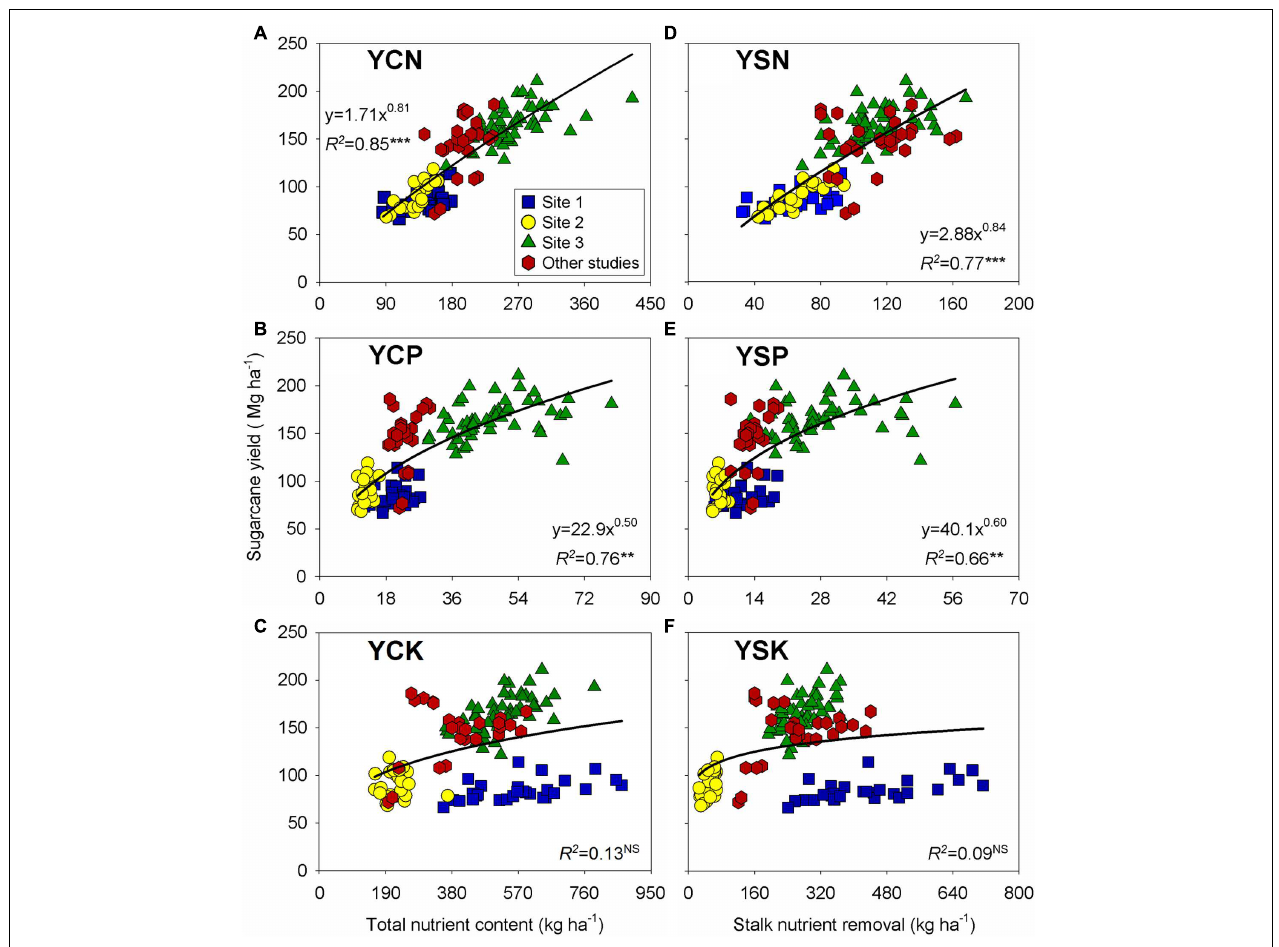
FIGURE 3 | Relationships between sugarcane yield versus aboveground nutrient content for N (A), P (B), and K (C); and versus stalk nutrient content (nutrient removal) for N (D), P (E), and K (F). Each data point represents an individual field plot at sugarcane harvest of a first ratoon growing season for three site-years ( n = 102). Red symbols were gathered from previously published documents (Shukla et al., 2009; Oliveira et al., 2010; Schultz et al., 2010; n = 27). ∗∗∗ , ∗∗ , and NS : p ≤ 0.001, p ≤ 0.01, and non-significant ( p > 0.05),